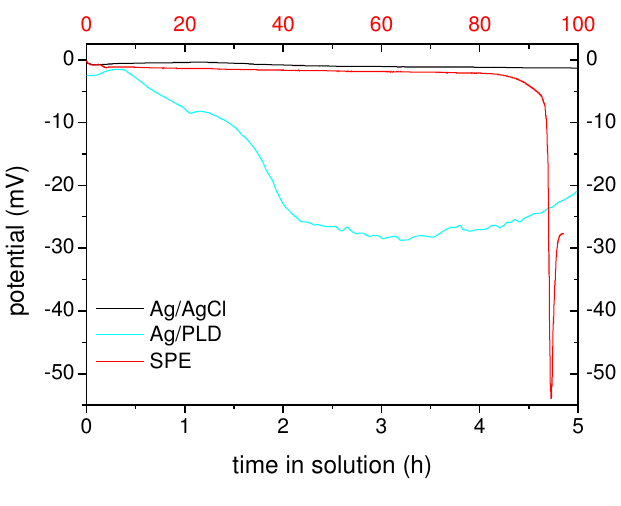
Figure 3. Potential stability of different miniaturised reference electrodes without KCl-containing membrane measured versus a conventional reference electrode.